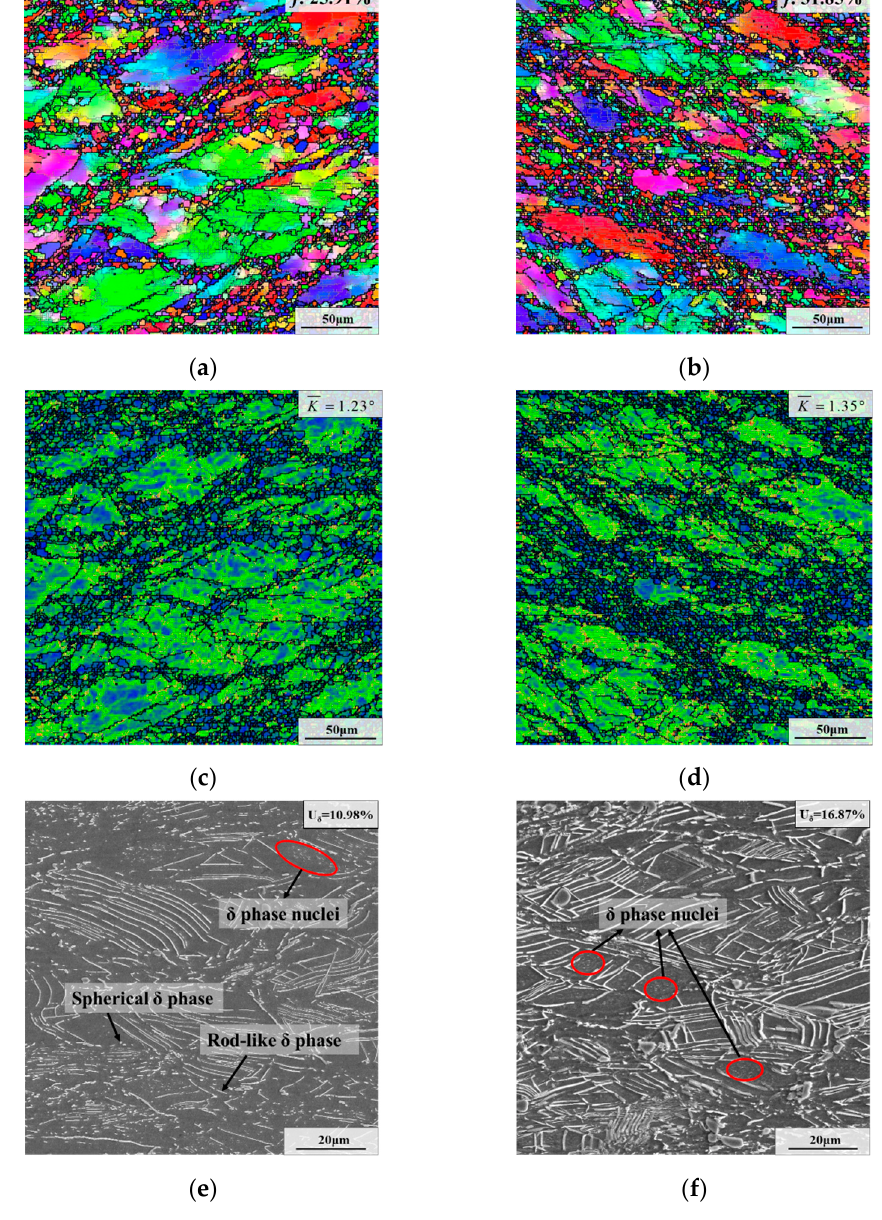
Figure 5. Deformed microstructures with varying strain rates of: ( a , c , e ) 0.001 s − 1 ; ( b , d , f ) 0.01 s − 1 . (The deformation temperature is 950 °C, and the true strain is 0.69.)